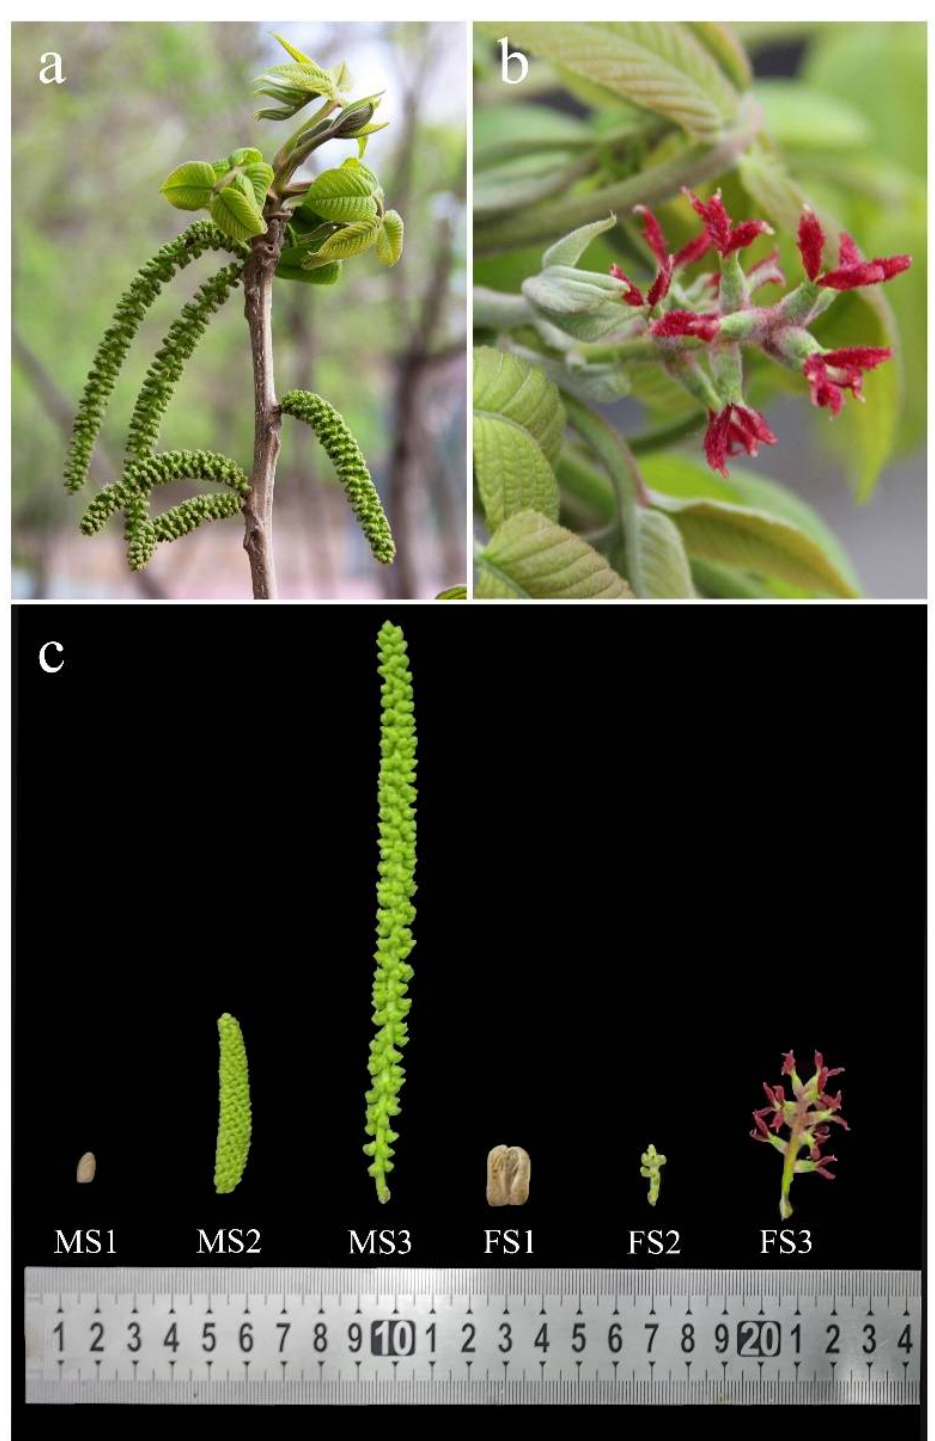
Figure 1. Morphological characteristics of male/female inflorescence of Juglans mandshurica . ( a ) male inflorescence; ( b ) female inflorescence; ( c ) the three key developmental stages of male (MS1, MS2, and MS3) and female (FS1, FS2, and FS3) inflorescence.